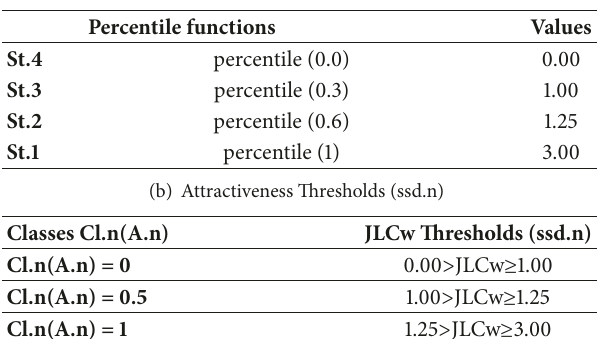
Table 8: MCSDA implementation for JLC: statistical analysis (a) and Thresholds of Attractiveness definition